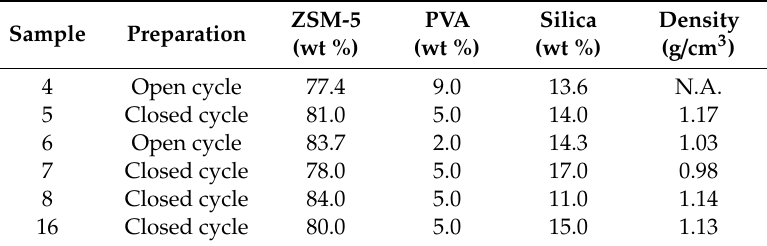
Table 1. Composition of ZSM-5-based extrusion pastes and extrudates density.